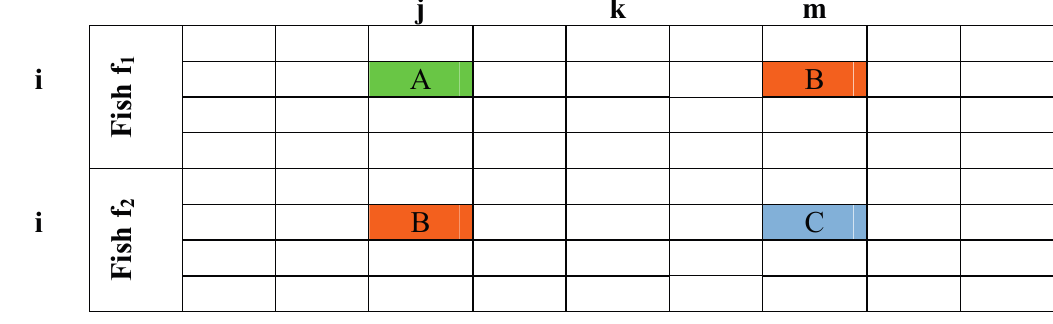
Figure 1. Two fish timetables which differ in cell ( i , j ).